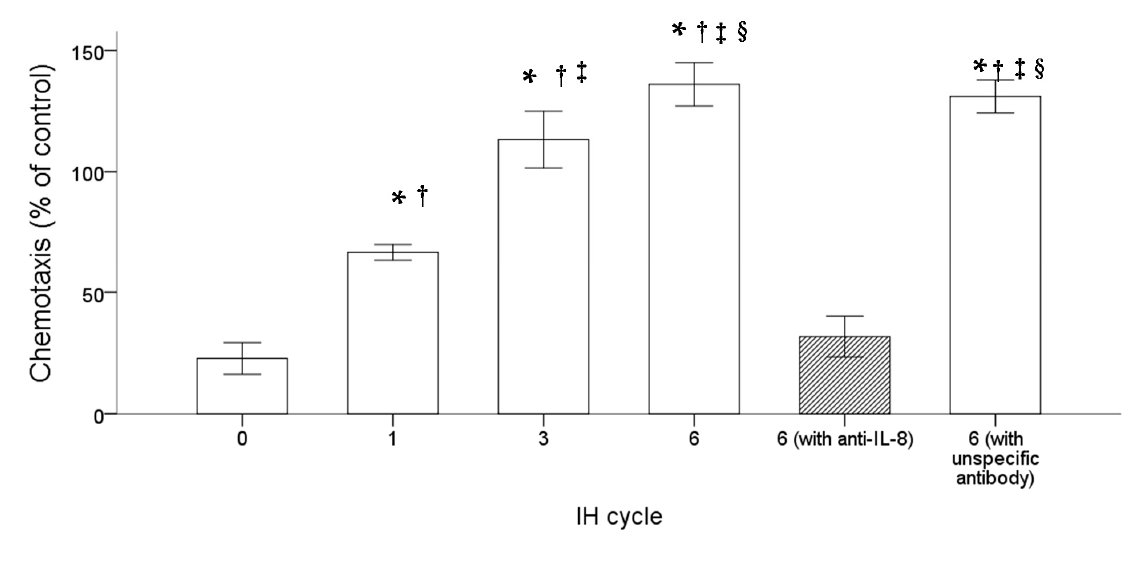
Figure 2. Intermittent hypoxia increased chemotaxis of monocytes with IL-8 dependence. THP-1 cells were treated with normoxia or intermittent hypoxia for one, three and six cycles, and the culture medium was collected as the attractant for the following chemotaxis process. Chemotaxis of the monocytic THP-1 cells toward IL-8 was analyzed by means of the transwell migration assay for 1 h toward the condition medium of the IH-treated THP-1 cells. ( a , b ) The number of THP-1 cells that were attracted by IL-8 and migrated through the transwell filter was increased by intermittent hypoxia and diminished by the anti-IL-8 antibody-pretreated conditioned medium. A control experiment to exclude the pure IgG effect with an unspecific antibody “mouse IgG1, Kappa Monoclonal (NCG01)-Isotype Control-BSA and Azide Free” was conducted, which showed no effect on the IL-8-induced migration. Note: The data were presented as the means and the standard errors from three independent experiments, * p < 0.05 vs. normoxia; † p < 0.05 vs. six IH cycles with anti-IL-8; ‡ p < 0.05 vs. one IH cycle; § p < 0.05 vs. three IH cycles. Abbreviations: IH = intermittent hypoxia; IL = interleukin.